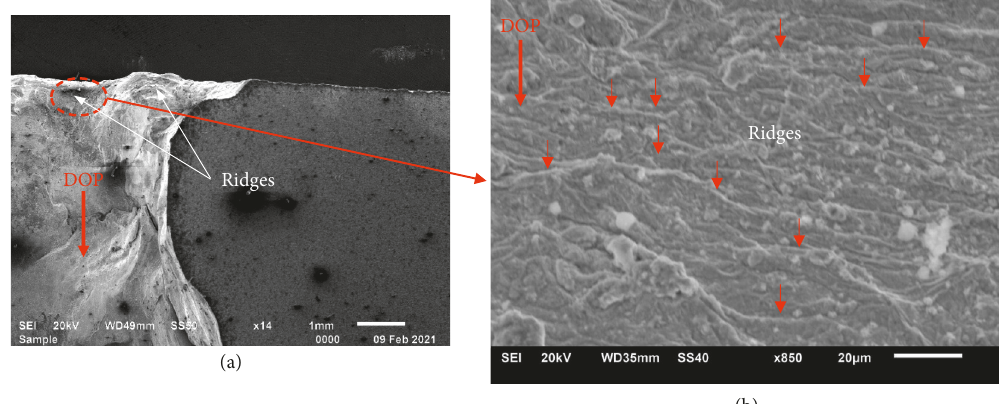
Figure 10: SEM SEI micrographs (a) at the entry point of the penetration hole through an 8mm thick plate and (b) a higher magnification micrograph of the circled area in